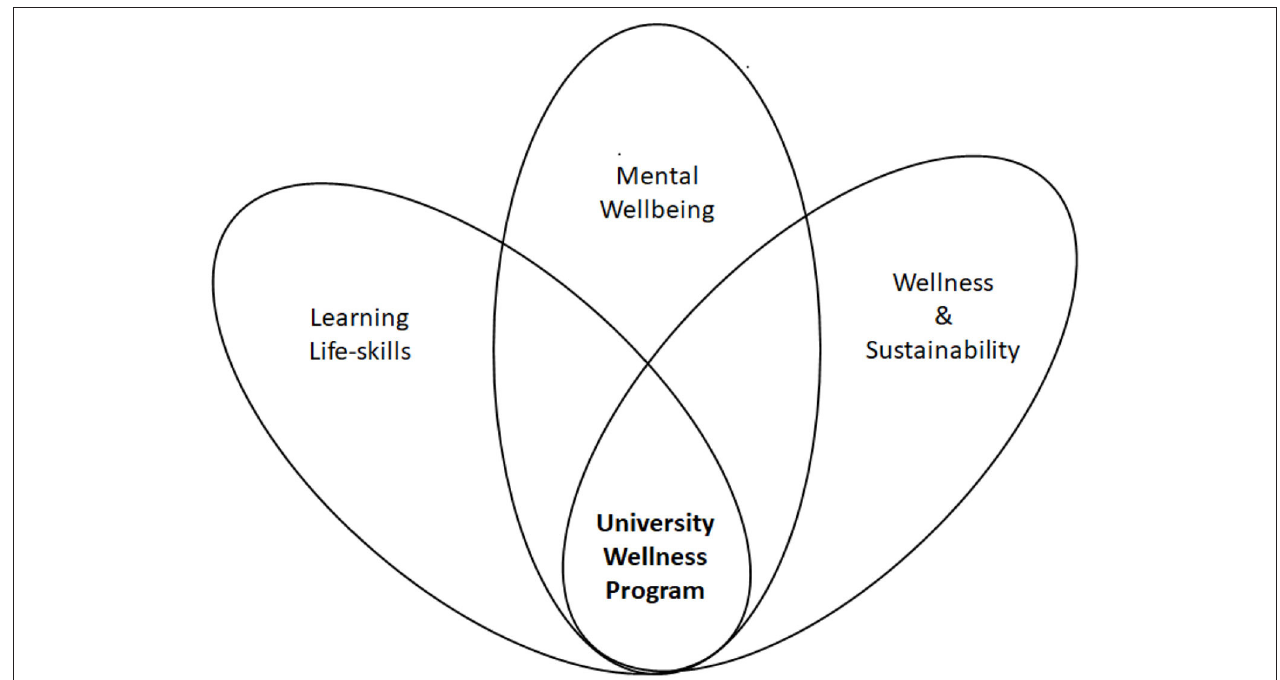
FIGURE 1 | Genesis of